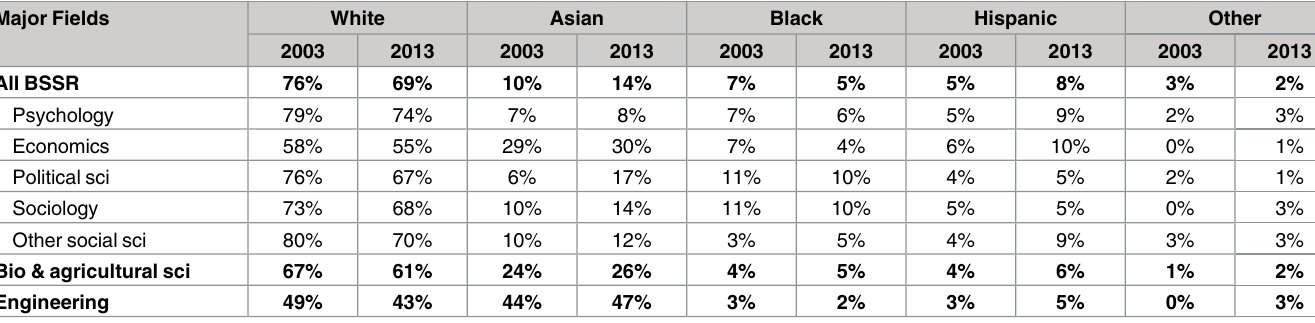
Table 4. Demographic trends of incoming PhDs in BSSR workforce by